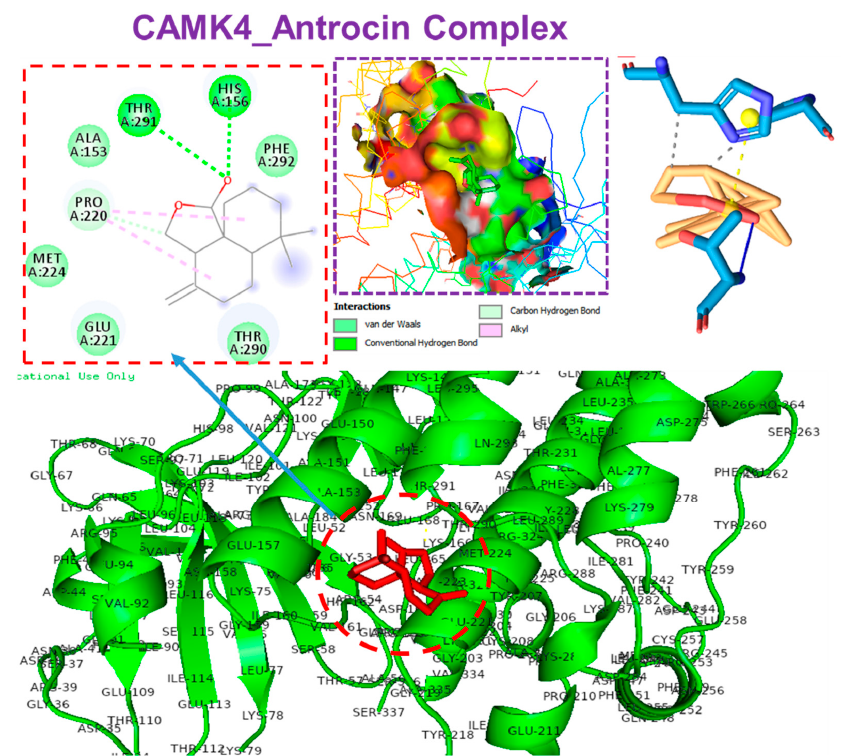
Figure 8. Molecular docking profile of CAMK4 with antrocin.